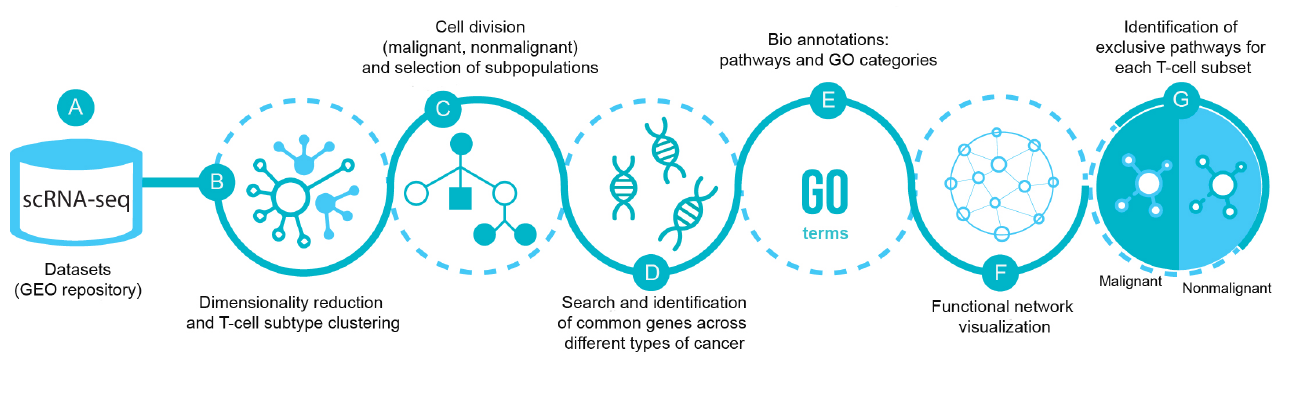
Figure 1. scRNA-seq pipeline. ( A ) Datasets of scRNA-seq were selected from Gene Expression Om- nibus (GEO) database from breast (GSE114727 and GSE75688), lung (GSE126030 and GSE99254), col- orectal (GSE108989), melanoma (GSE72056 and GSE123139), and head and neck cancer (GSE103322). ( B ) The data were processed using dimensionality reduction and clustering techniques in order to separate T-cells and their subpopulations CD4-T, CD8-T and Treg cells ( C ) from malignant and nonmalignant origin. ( D ) Then, common genes across the different types of cancer from malignant and nonmalignant origin were selected and ( E ) pathways and GO categories to profile the gene selection were obtained from Gene Ontology (GO) and Reactome databases. ( F ) Visualization using Cytoscape and ClueGO plugin for biological process and ( G ) differentiation of the functions among conditions of the subpopulations of T-cells were